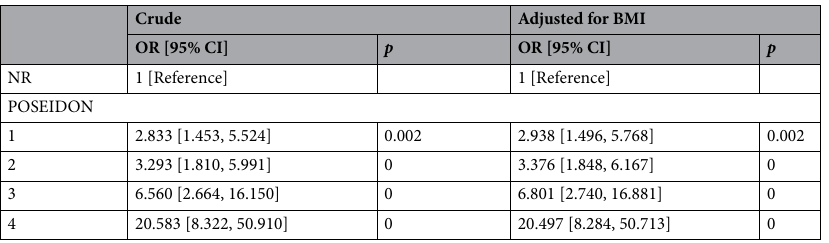
Table 4. Binary logistic regression for ART outcomes of no pregnancy among POSEIDON groups compared to the NR group. Odds ratios are presented with 95% confidence interval. A p-value < 0.05 was considered statistically significant. OR odds ratio, CI confidence interval, NR normal responder, BMI body mass index, POSEIDON patient-oriented strategies encompassing individualized oocyte number, ART assisted reproductive